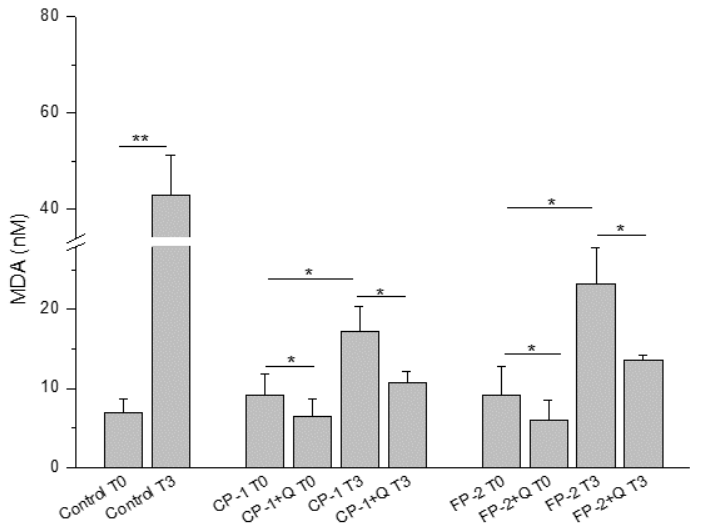
Figure 1. MDA levels in HAM ‐ derived supernatants obtained immediately after thawing (T0) and after 3 days of HAM culture (T3). Control: supernatants from fresh not preserved HAM; CP ‐ 1: cryopreservation protocol 1; FP ‐ 2: freezing protocol 2; Q: quercetin. Data are represented as mean ± SD of 3 independent experiments. * p < 0.05 and ** p < 0.01 between the indicated bars.